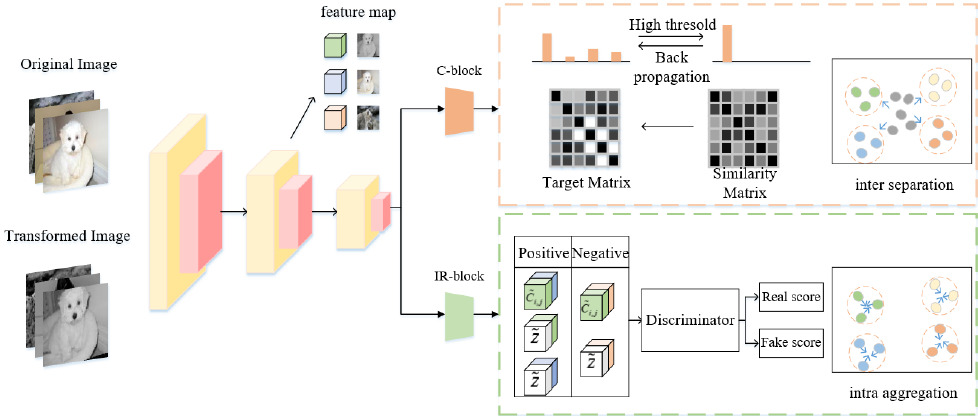
Figure 1. Model Overview. The original image and its transformed image are regarded as a pair of inputs to learn class-level (C-block) and instance-level (IR-block) representations using a shared deep neural network. The similarity matrix is generated from the class-level feature similarity relationship of the transformed images, and the target matrix is generated using K-means in the original image class-level feature space to guide the similarity matrix. Cluster standard samples are selected according to the threshold to modify the network parameters. The discriminator network estimates the mutual information of local-global and local-local representations,